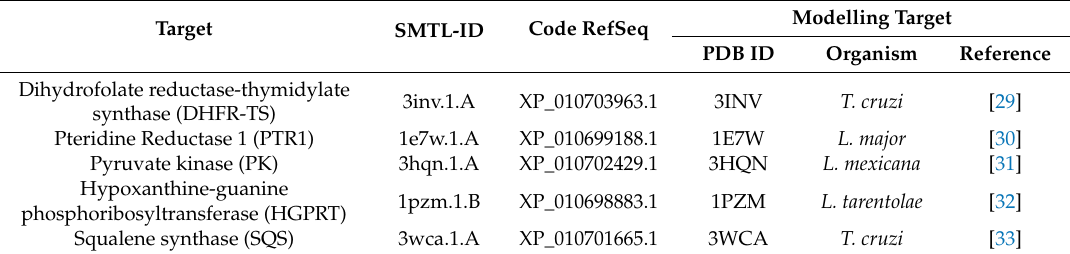
Table 2. Studied targets and modelling code references.